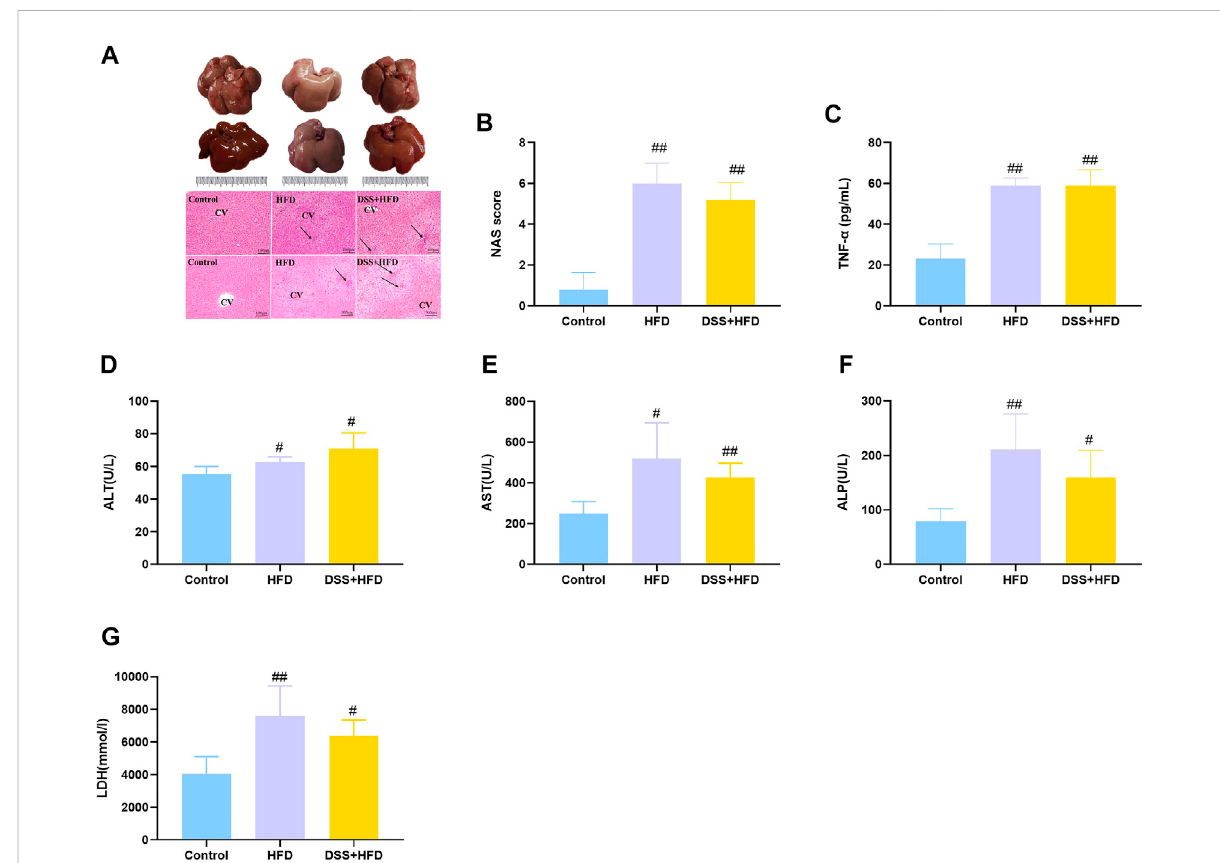
FIGURE 3 Evaluationofhepaticsteatosis. (A) MacroscopicliverappearanceandliverhistologyasshownbyHEstainingofliver.Picturesweretakenundera microscopywithobjectlensesof×10.Blackarrowspointatin fl ammatorycells.CV,centralvein (B) NAFLDActivityScore(NAS)analysis. (C) TNF- α . (D) ALT. (E) AST. (F) ALP. (G) LDH. Values are the means ± SD ( n = 5). Control: standard chow; HFD: high fat diet; DSS + HFD: high fat diet +1% DSS in drinking water. # p < 0.05, ## p < 0.01, vs. the control group. ** p < 0.01, vs. the HFD